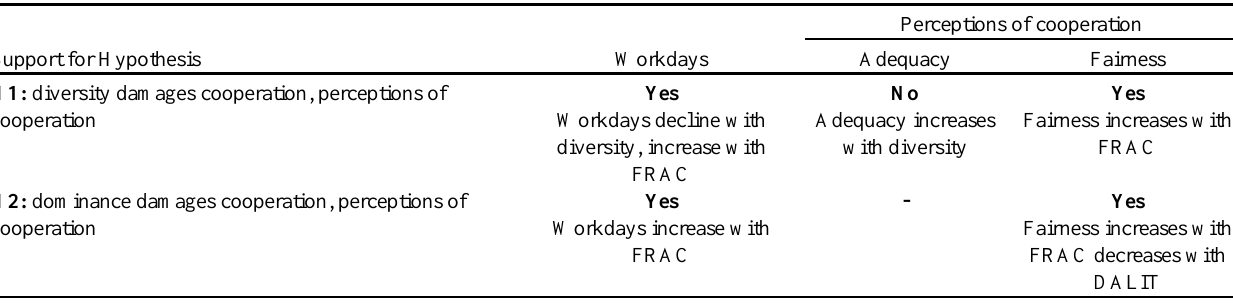
Table 5. Multiple regressions provide support for both hypotheses. Hypothesis 1 - Increasing ethnic diversity reduces community cooperation and perceptions of collective action efforts. Hypothesis 2 - Ethnic dominance additionally reduces cooperation and collective action perceptions. The effects of the FRAC variable support of both dominance and diversity hypotheses because membership in a larger ethnic group simultaneously decreases ethnic diversity and increases ethnic power differentials, the fundamental aspect of ethnic